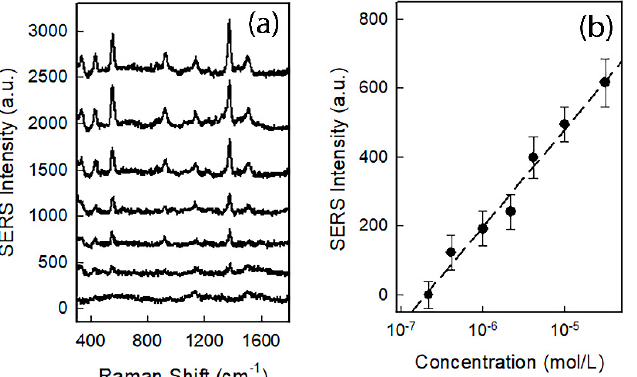
Figure 9. ( a ) Spectra of SERS chips after incubation in EtOH solutions of thiram with concentration ranging from 2.2 × 10 − 7 (lower spectrum) to 3.2 × 10 − 5 M (upper spectrum); ( b ) calibration curve obtained from mode at 1375 cm − 1 (r 2 = 0.982).